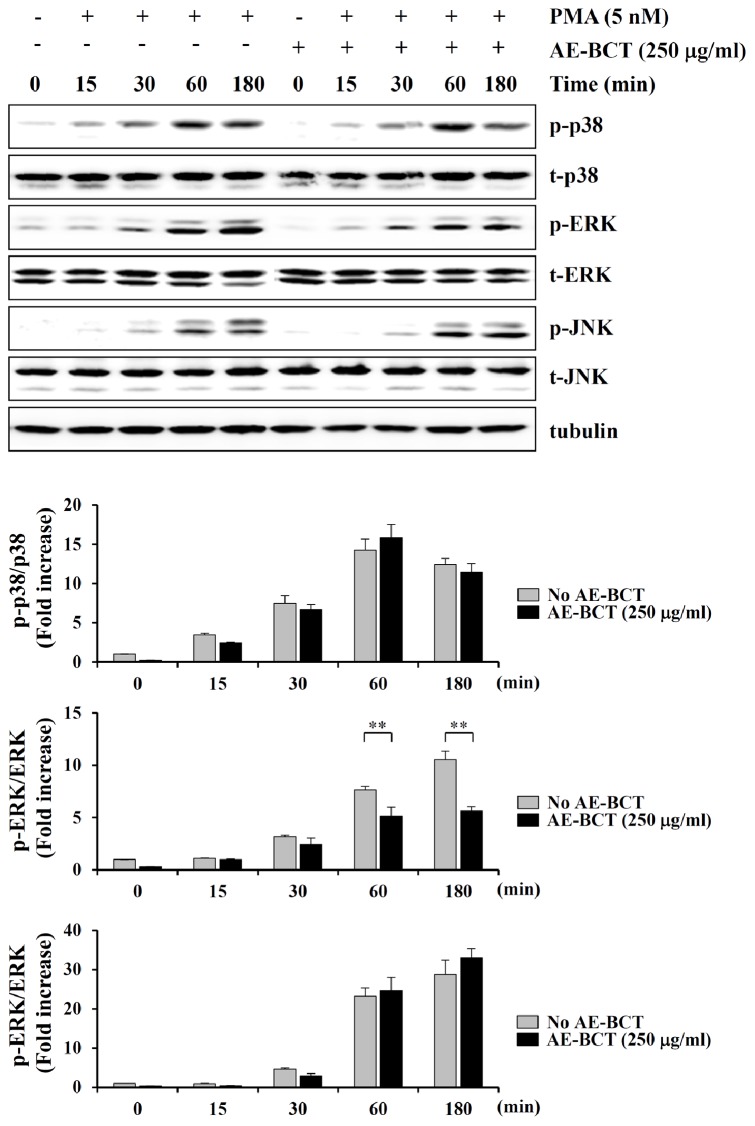
Effect of AE-BCT on MAPK activation in HT1080 cells.Control and AE-BCT-pre-treated HT1080 cells were stimulated with 5 nM PMA for the indicated period of time and cell lysates were subjected to Western blotting of the phosphorylation of p38, ERK, and JNK. Relative ratios of phosphorylated forms to total levels were determined after normalization to α-tubulin expression. Data are expressed as means ± SD of two independent experiments. **p<0.01 vs no AE-BCT.